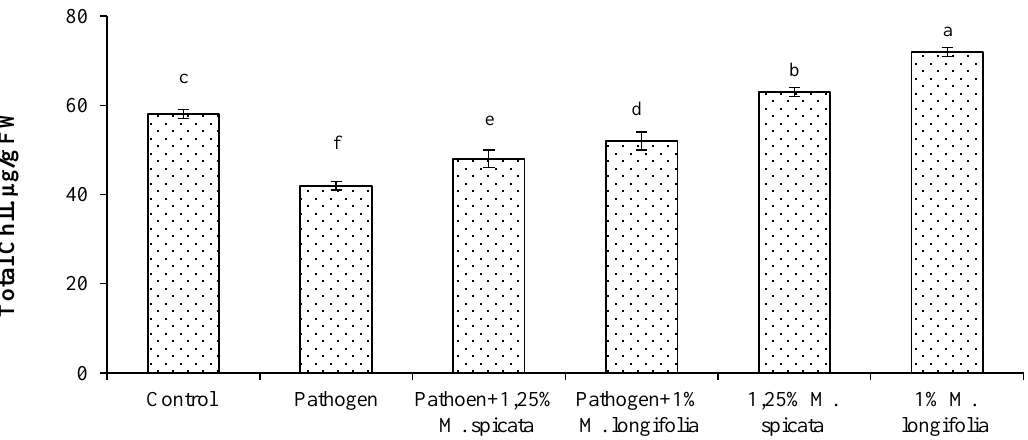
essential oils. Different letters indicate significant differences between different treatments at p ≤ 0.05. Data are expressed as the mean of three replicates ± SDs.